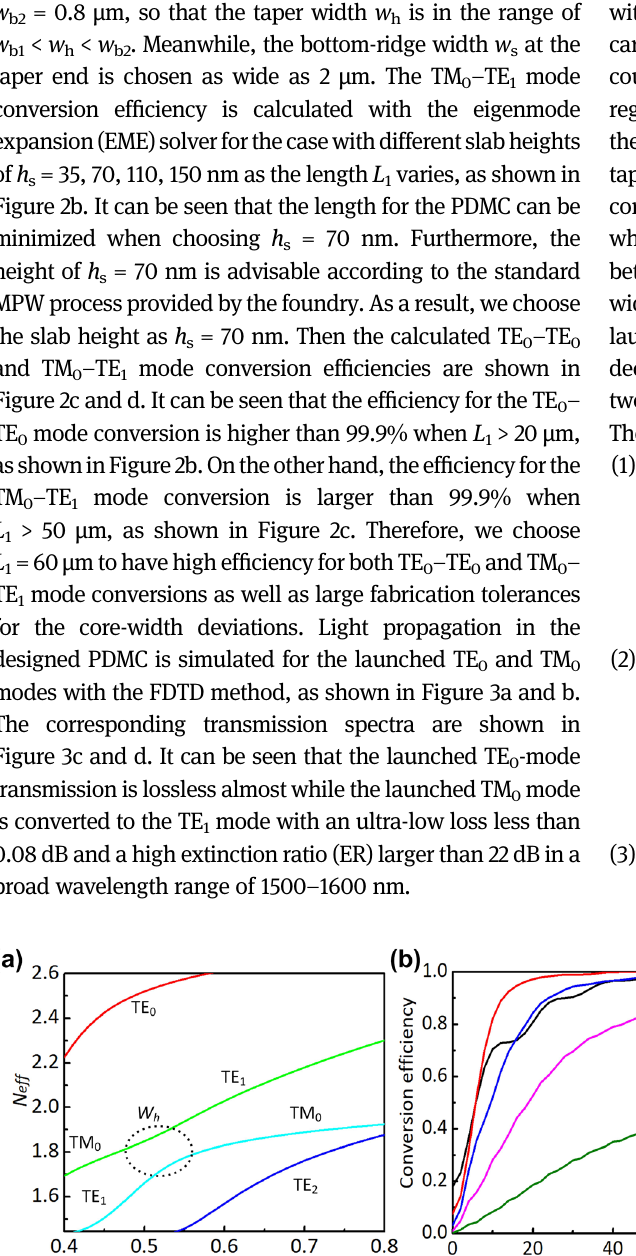
Figure 2: Design of the